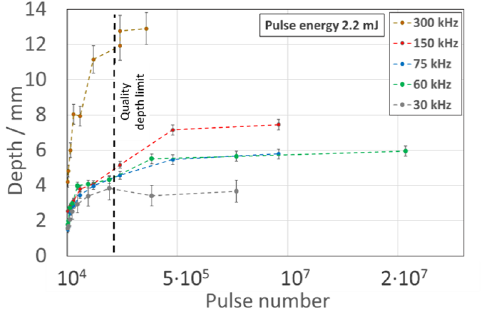
Fig. 7. Hole depth as a function of the number of pulses for the pulse energy of 2.2mJ for different repetition rates.